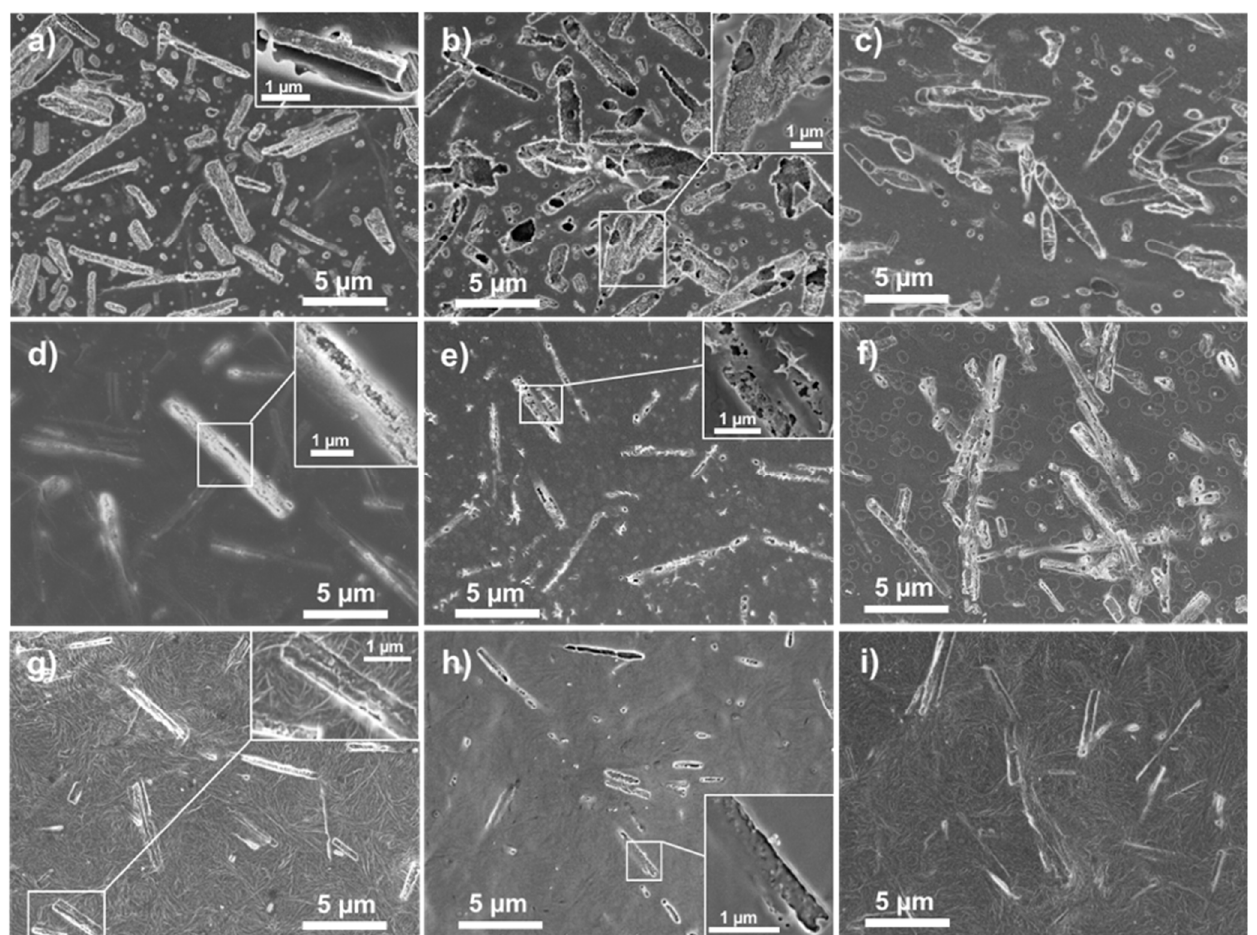
Figure 4. SEM visualised surface morphology of: MgO/PLGA composite coating after exposure to physiological solution and linear shaking for ( a ) 2 h, ( b ) 4 h and ( c ) 24 h; MgO/PLA composite coating after exposure to physiological solution and linear shaking for ( d ) 2 h, ( e ) 4 h and ( f ) 24 h; MgO/PCL composite coating after exposure to physiological solution and linear shaking for ( g ) 2 h, ( h ) 4 h and ( i ) 24 h.